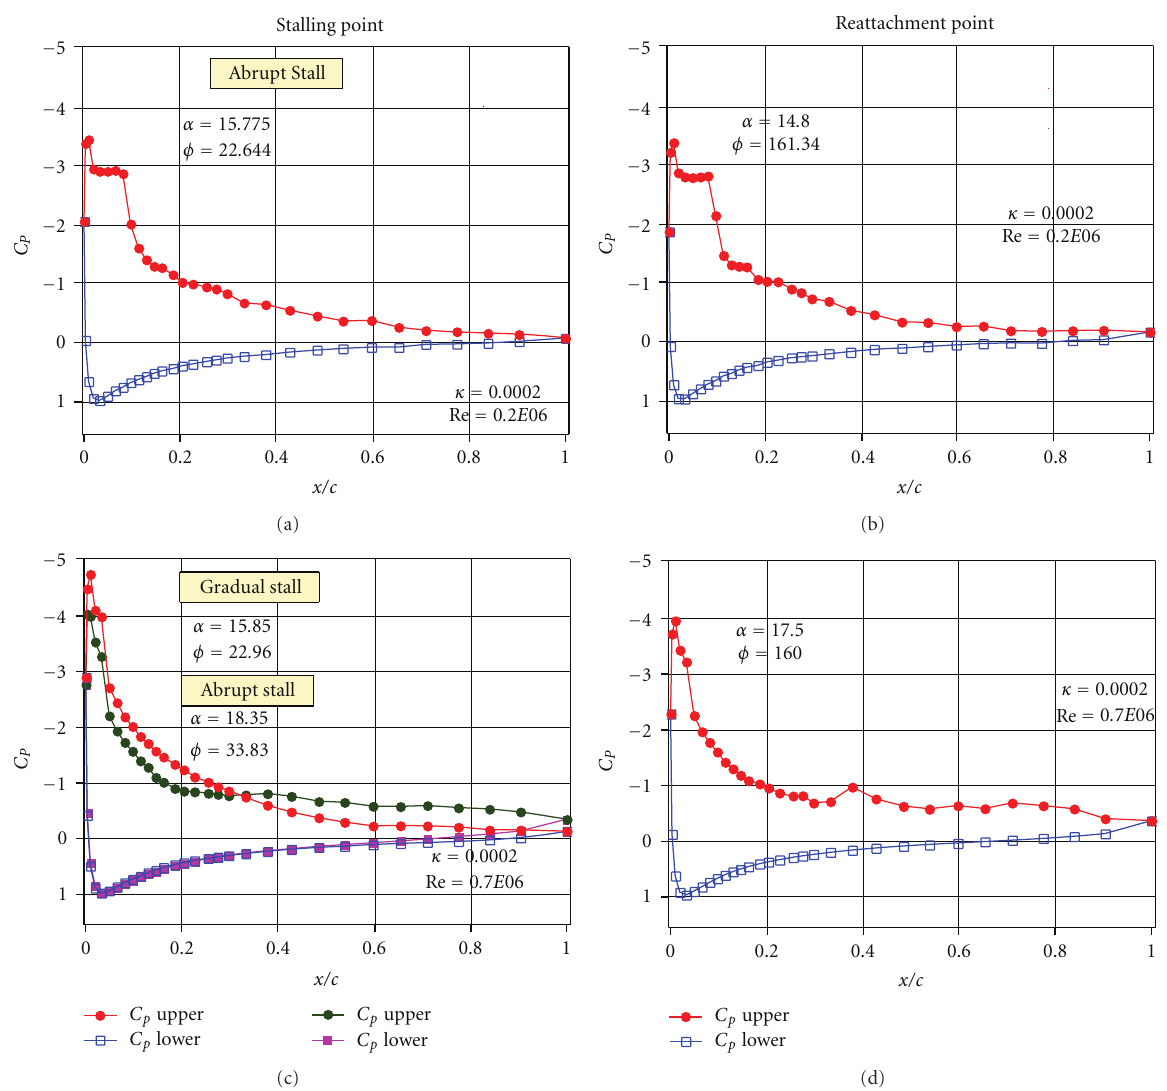
increase in Re shows substantial reduction in the intensity